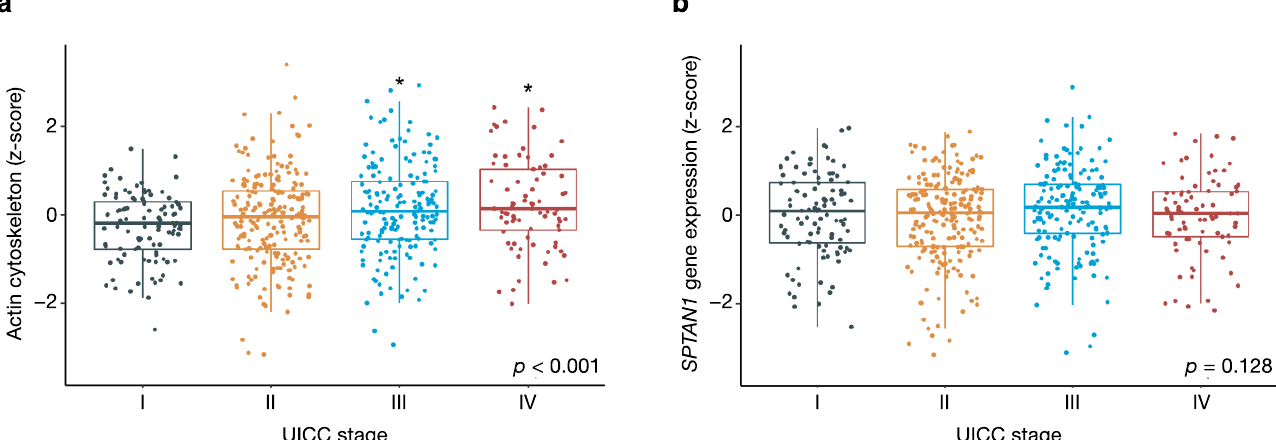
Figure 2. Actin cytoskeletal genes are upregulated in aggressive tumours with distant metastasis. Box plots showing the respective associations between ( a ) UICC stage and actin cytoskeletal gene expression, and between ( b ) UICC stage and SPTAN1 gene expression. The analysis is based on gene expression data from the TCGA cohort (573 patients). Actin cytoskeletal gene expression in ( a ) was quantified using the GenePattern ssGSEA module. Population means in both ( a ) and ( b ) were compared by one-way ANOVA, and the corresponding p -values are shown. Differences between individual UICC stages and the reference group (UICC stage I) were assessed by Dunnett’s post-hoc test, and denoted with an asterisk (*) if they reached statistical significance. Results with a p -value < 0.05 were considered statistically significant.